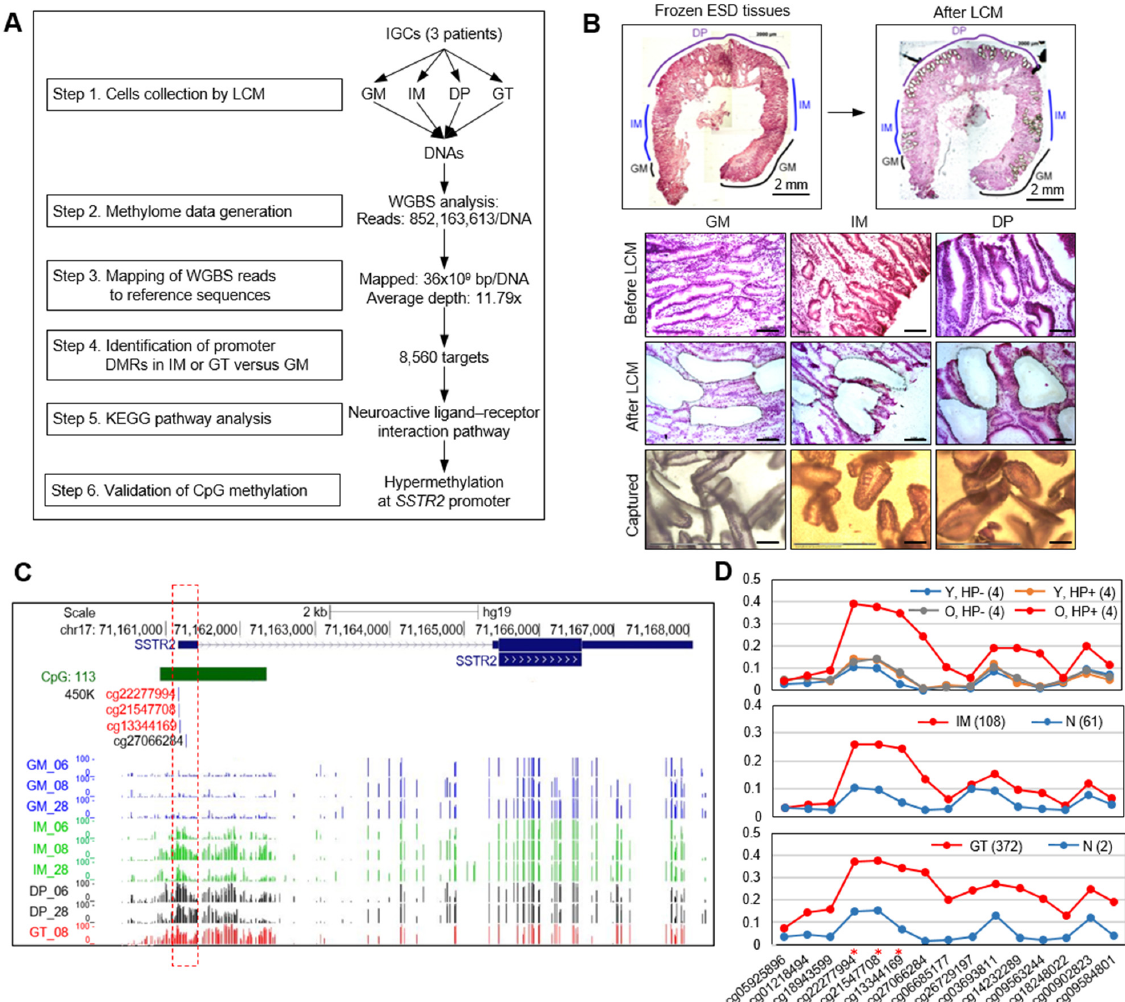
Figure 1. Methylome analysis for gastric tumors and the precancerous lesions. ( A ) Schematic diagram for WGBS analysis with clinical tissues. The six-step process was progressed for the initial methylome profiling and identification of promoter DMRs and a significant pathway associated with gastric carcinogenesis. ( B ) A representative example for isolation of gastric mucosa (GM), intestinal metaplasia (IM), and dysplasia (DP) cells from frozen ESD tissues of one patient (#06) with intestinal gastric cancer using LCM procedure. Upper panels show photos marked with gastric lesions before (left) and after (right) LCM. Lower panels also show photos enlarged before (top) and after (middle) LCM and captured tissues (bottom) for GM, IM, and DP cells, respectively. ( C ) Meth- ylation profiles on SSTR2 gene in GM, IM, DP, and GT cells. Top shows gene structure modified from UCSC Genome Browser (hg19): chr17: 71,160,089–71,168,292. Middle shows CpG probes that were selected for 450K methylation array. WGBS data of three patients (#06, #08, and #28) with EGC was visualized on UCSC genome browser as GM (blue colored), IM (green), DP (black), or GT (red) cells. The height of each colored vertical bar shows the extent of methylation within the range of 0 to 100 at single CpG site. Red dotted rectangle highlights hypermethylated promoter region, in which red-colored three CpG sites (cg22277994, cg21547708, and cg13344169) were chosen for pur- poses of comparison with the previous data for GM, IM, or GT tissues using 450K methylation array. ( D ) Detailed CpG methylation at promoter regions of SSTR2 gene. The data was derived from 450K methylation data of GM (up), IM (middle), and GT (bottom). In case of GM, the 450K methylation data for four categories of each four samples (Yamashita et al., 2019) was used for this analysis: Y, HP (cid:3398) (blue line), young, and H. pylori -negative; Y, HP+ (yellow), young, and H. pylori -positive; O, HP (cid:3398) (gray), old, and H. pylori -negative; O, HP+ (red), old, and H. pylori -positive. In case of IM, the 450K methylation data for 108 IM and 61 normal tissues from GSE103186 were used, while for GTs, 372 GTs and two normal tissues from The Cancer Genome Atlas (TCGA) were used. At the top in